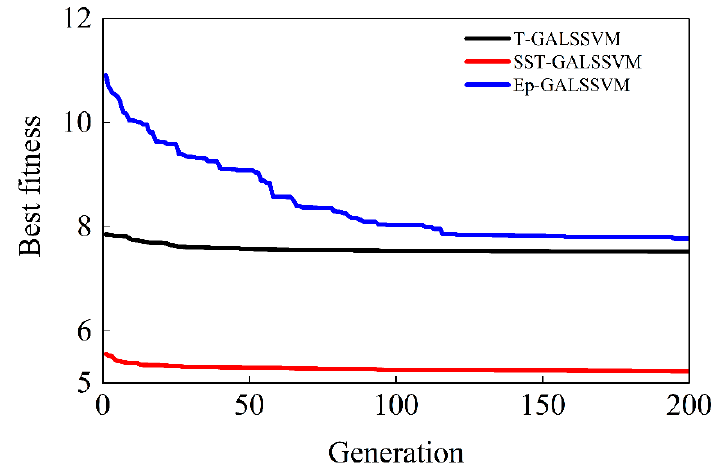
Figure 6. Parameter optimization based on GA.